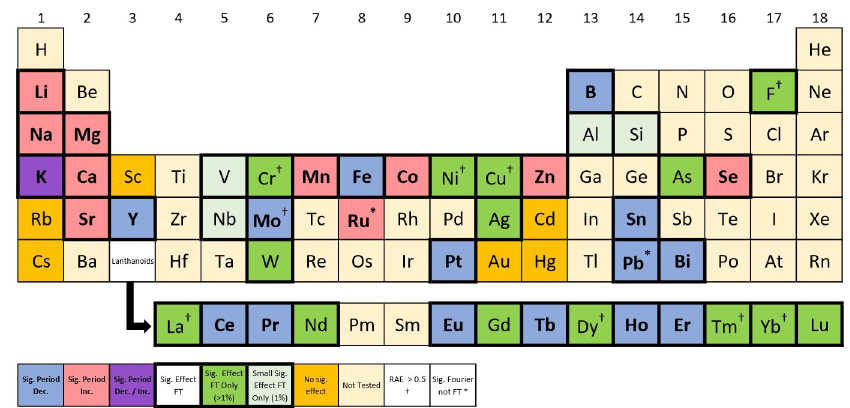
Fig 3. Combined output of FFT–NLLS and LSW–FT methods allows further insight into the impact of excess elements. For each method, an element (see Tables 1–3) is defined as having a significant effect if at least one corresponding chemical treatment gave a significant result (a statistically significant result which also follows the specific method’s usability criteria). Colours/ bold font / bold outline denote the type of induced change (see key).